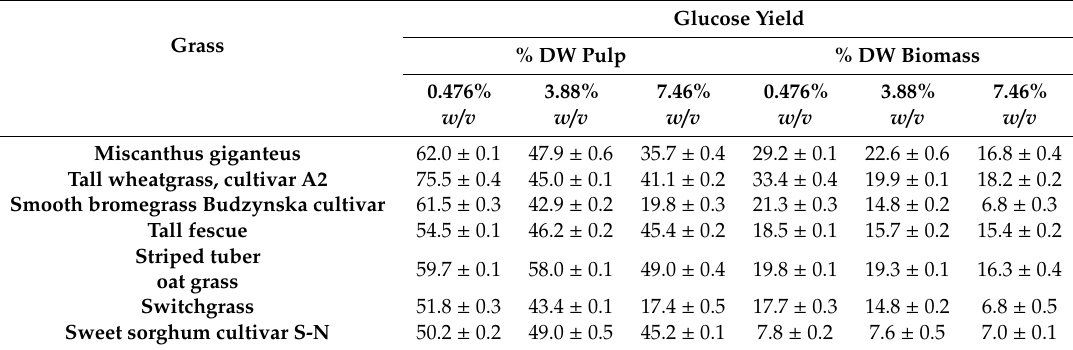
Figure 3. The effect of pulp concentration on the yield of reducing sugars after 24 h hydrolysis of the kraft pulps tested (note: values are the means of triplicate assays). Table 6. Glucose yields from the grasses at 3 concentrations of kraft pulps (0.476, 3.88 and 7.46% w/v ) derived from them (enzyme load 0.1 mL/g, 24 h hydrolysis at 50 °C).